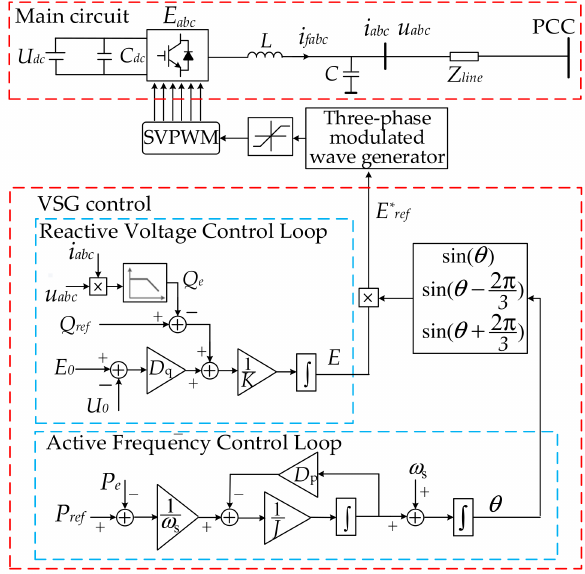
Figure 1. Topology and control scheme of the